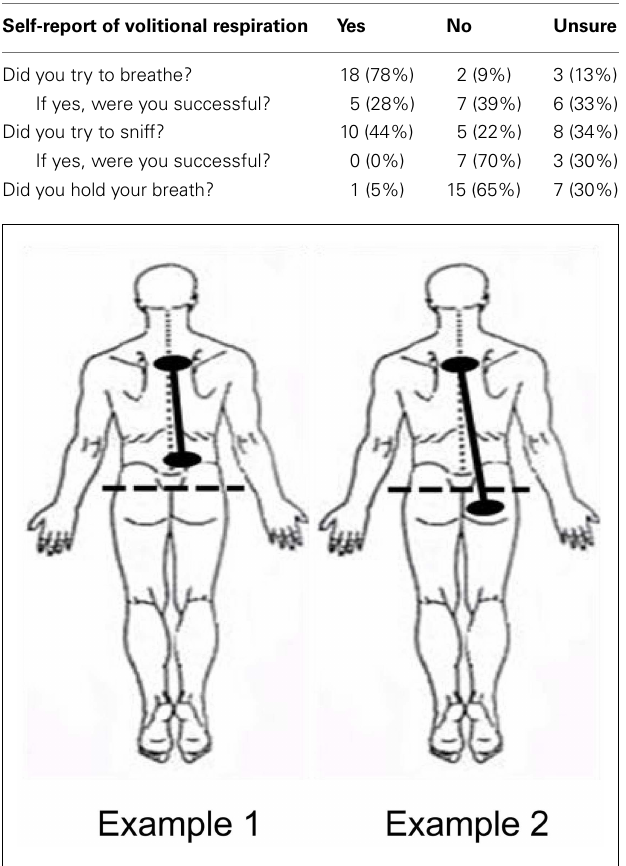
FIGURE 4 | Example of ECD exposure